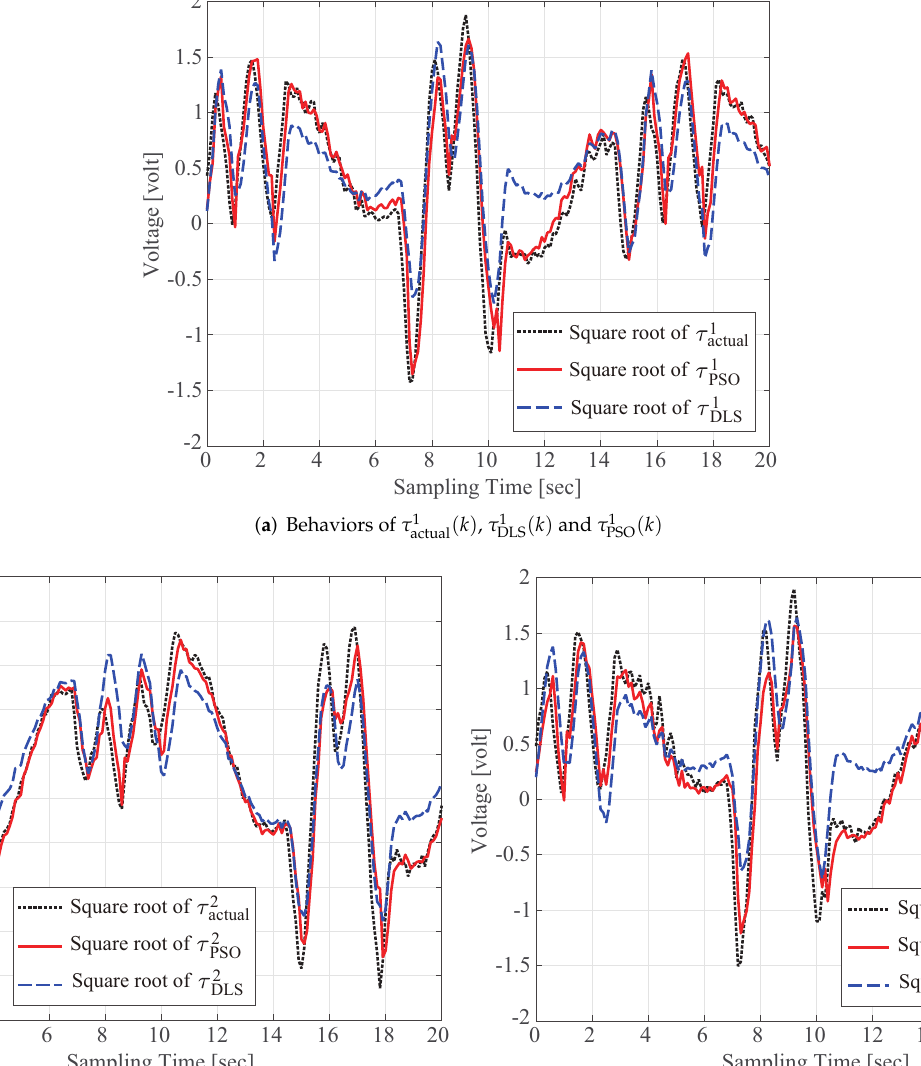
Figure 8. Comparison of the measured actual torque τ actual , the torque τ i damped least-squares (DLS)-based identification, and the torque τ i the identified parameter values in